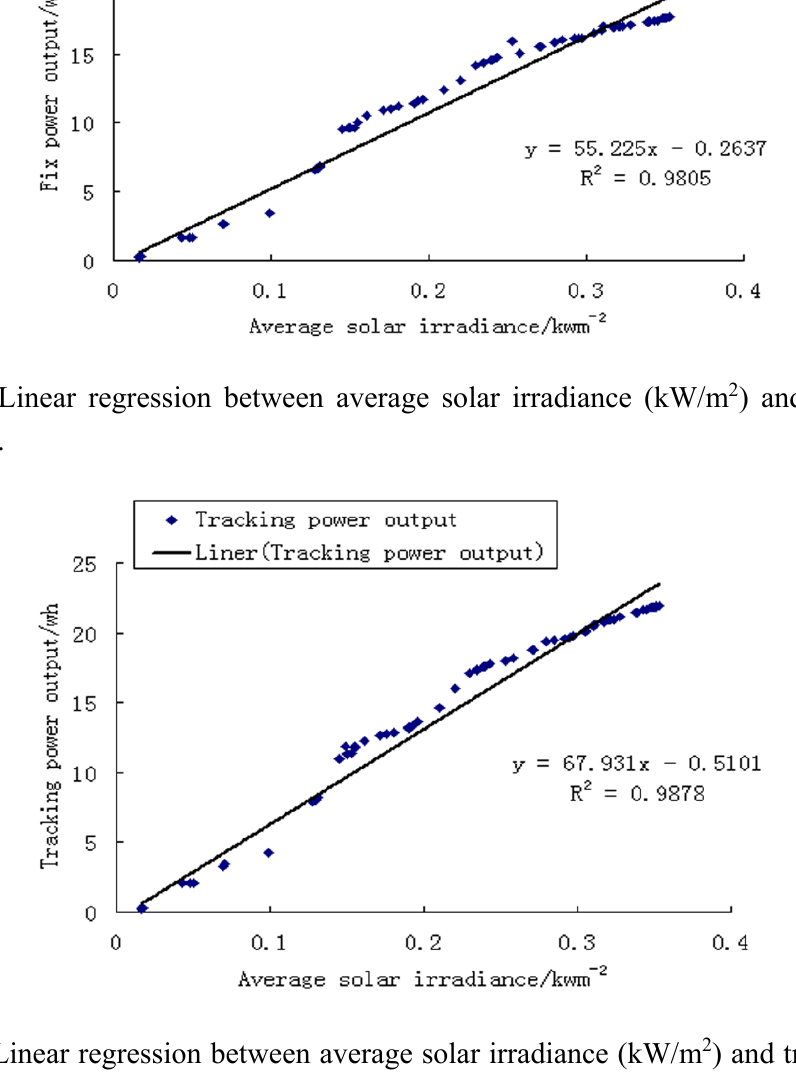
Figure 11. Linear regression between average solar irradiance (kW/m 2 ) and tracking solar output